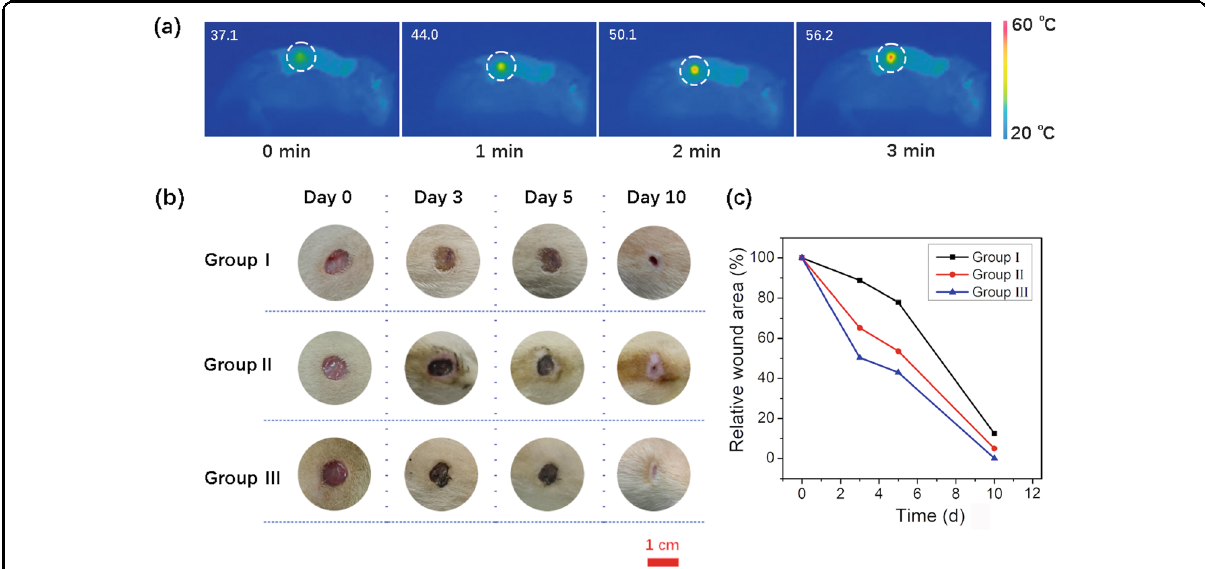
Fig. 3 Evaluation of wound closure with NC hygrogel. a Photothermal images of a rat treated with NC hydrogel under NIR irradiation (808 nm, 1.0 W cm − 2 ) for 0 – 3 min. b Representative images of skin wounds treated with PBS (Group I), NC hydrogel (Group II), and NC hydrogel + NIR (Group III). c Relative wound area curves of rats after different